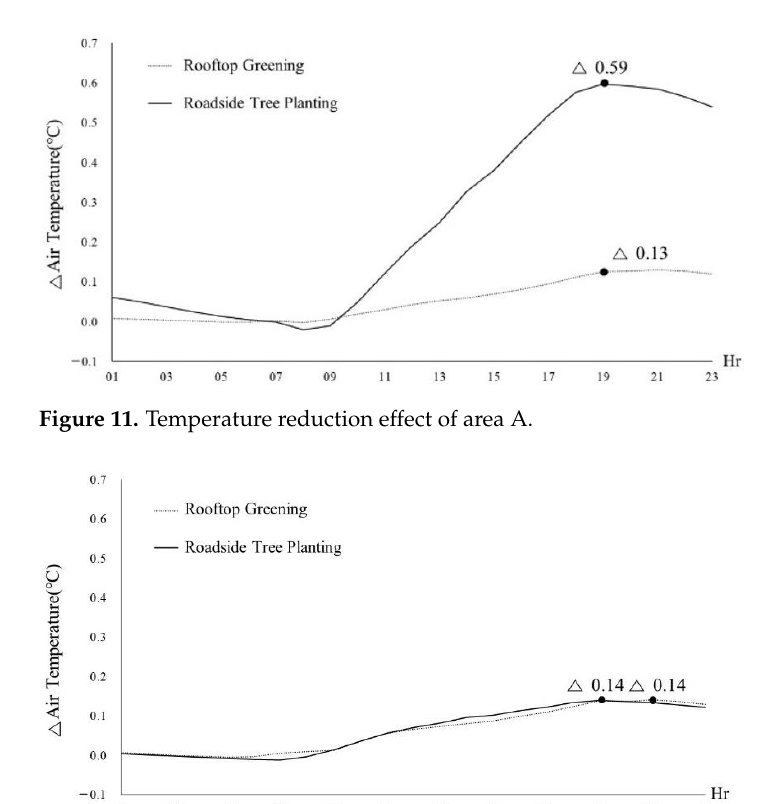
Figure 10. Results of the Envi-met simulation.